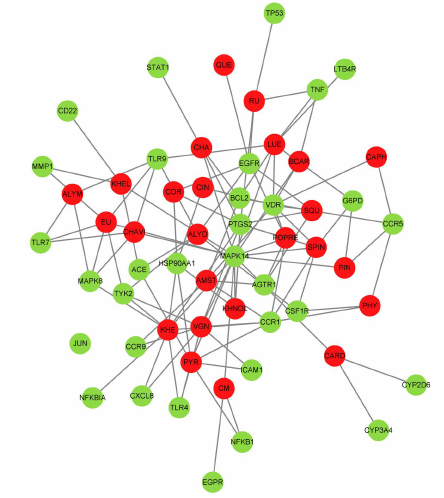
Figure 1. ORA predicts the involvement of genes in various activities.